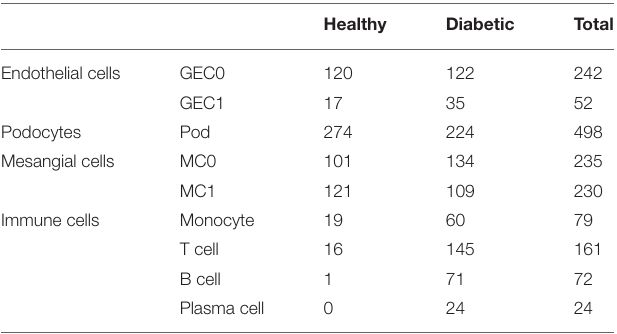
TABLE 1 | Cell counts in glomeruli from healthy subjects and patients with diabetic nephropathy. Healthy Diabetic